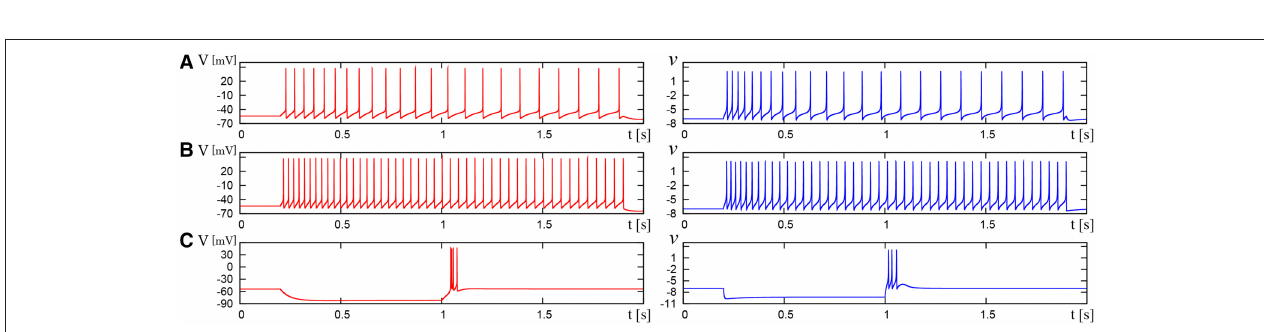
FIGURE 10 | Waveforms of Pospischil and DSSN models, corresponding to a neuron in the LTS class. The Pospischils’ model (left) generates periodic spikes in response to a step input rising at t = 0.2 where I stim is (A) 0.34, (B) 0.79, (C) –0.6 nA. The DSSN model (right) generates periodic spikes in response to a step input rising at t = 0.2 where I stim is (A) 0.278, (B) 0.308, (C) –1.7. (A,B) Pospischils’ model (left) and DSSN model (right) generate periodic spike in response to a depolarizing step input rising at t = 0.2 . (C) A hyperpolarizing step input is applied from t = 0.2 to t = 1.0 .